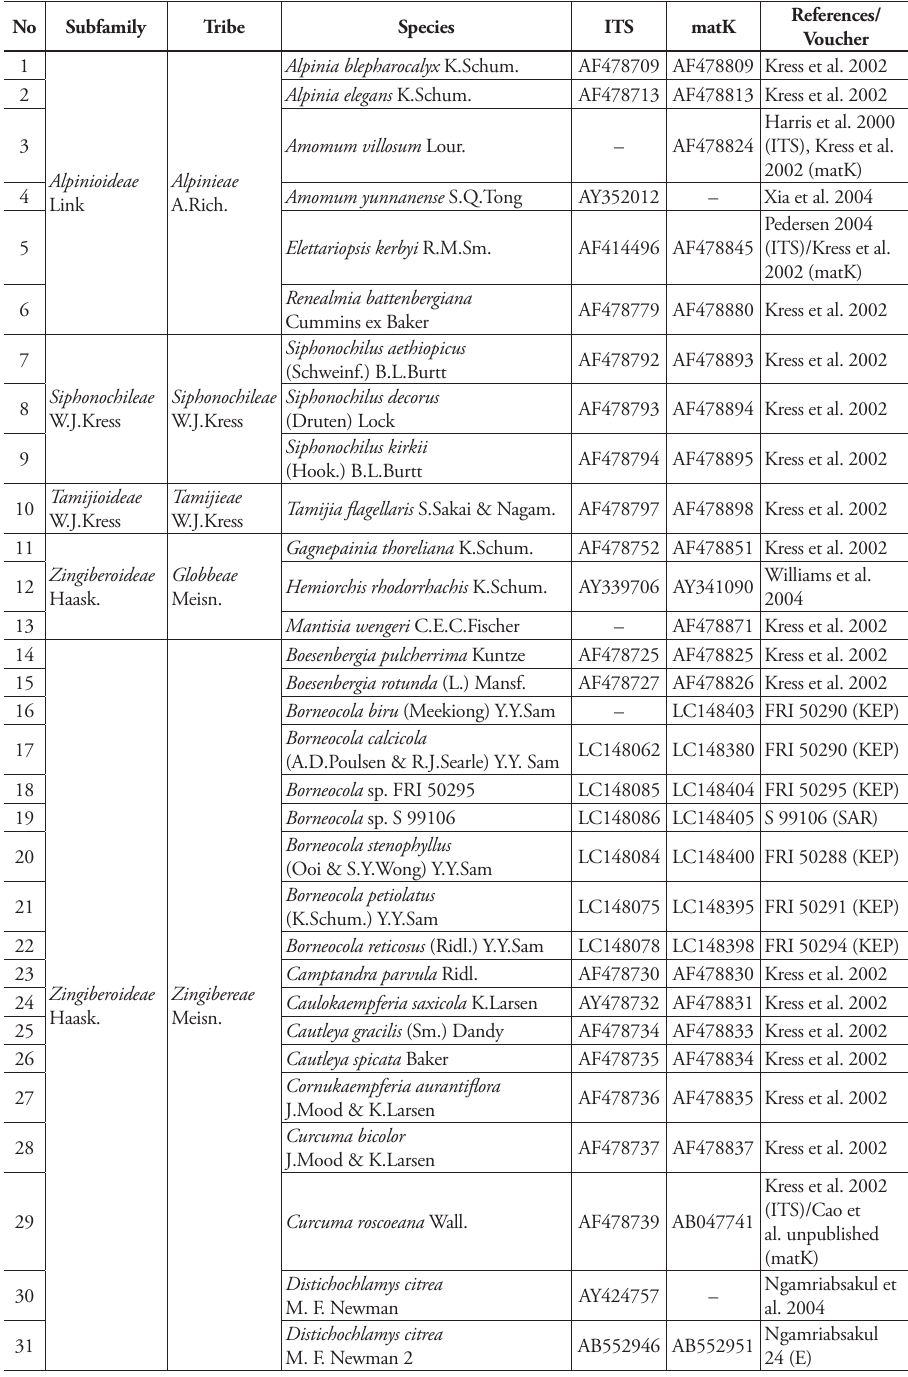
Table 1. List of accession details, vouchers and references used in the phylogenetic analyses. No